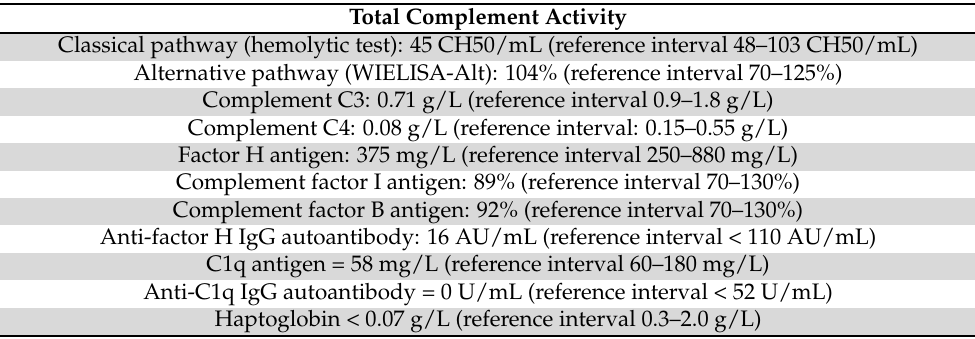
Figure 1. ADAMTS13 analysis in a patient with suspected aHUS. Table 2. Total complement activity analysis before treatment initiation for TTP.